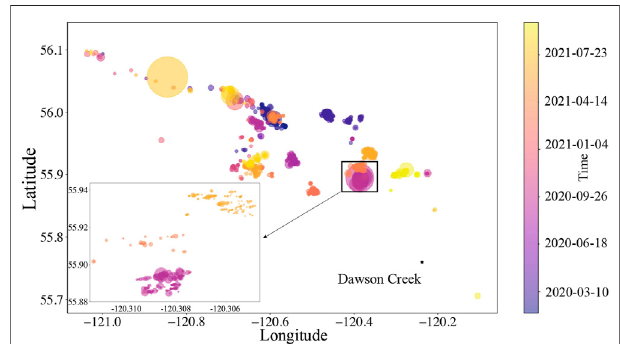
FIGURE 1 | Spatial map of seismic events in KSMMA catalog; 14,159 seismic events (from − 0.93 to 3.72 ML) were detected and located during January 21, 2020 to September 30, 2021. The color intensity shown is associated with the passing of time. The radius is associated with the size of the earthquakes. Only events above magnitude of completeness ( m c = 1.4) are shown here.